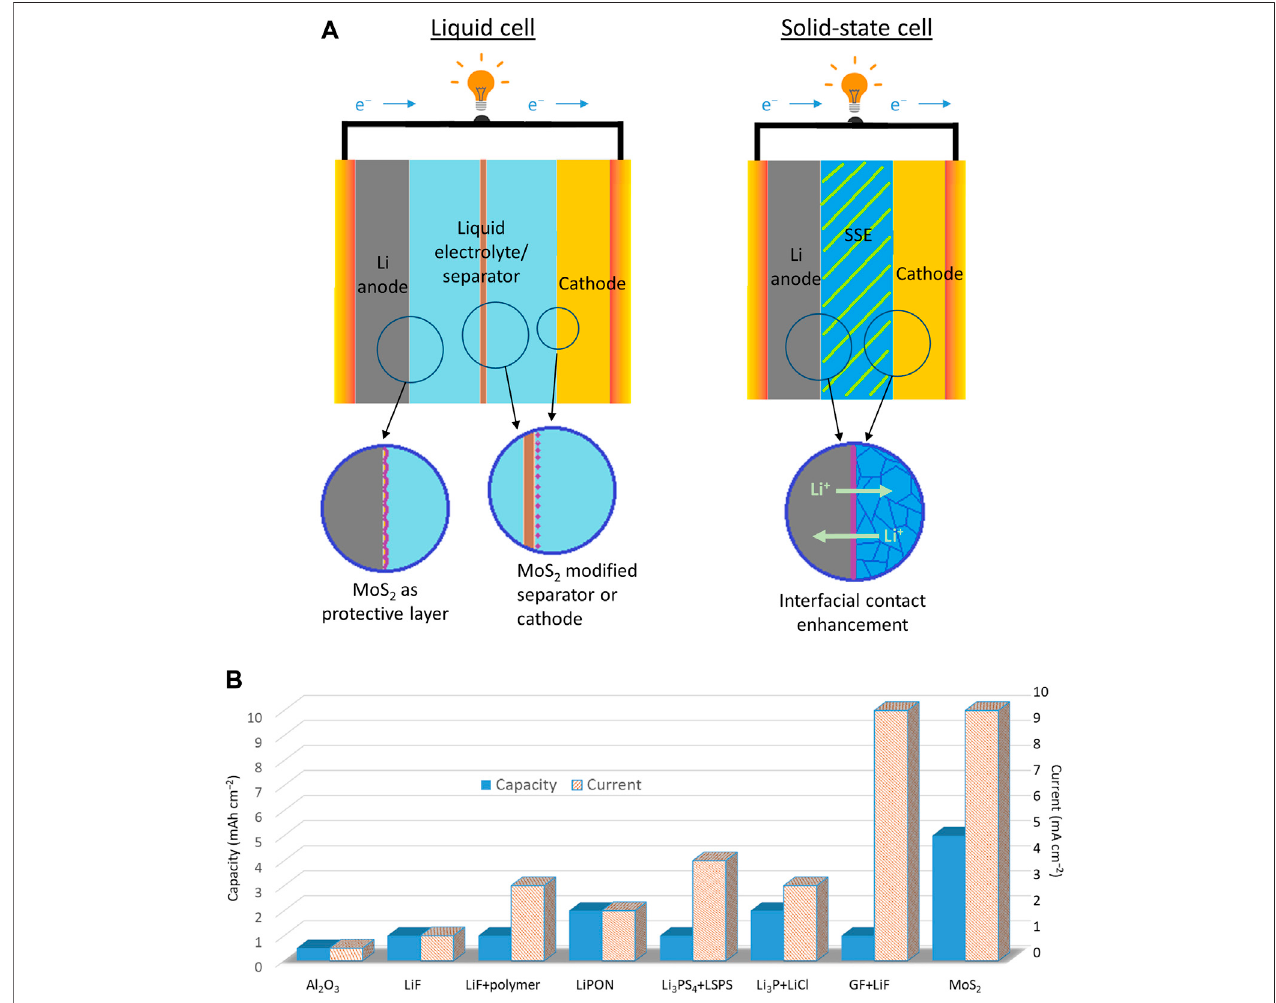
FIGURE1|(A) Applications ofMoS 2 forLimetalbatterysystemsfromliquidcellstosolid-state cells. (B) ThestatisticalanalysisofLi||Lisymmetriccellswithvarious coatings on theLimetal. References forthereported results: Al 2 O 3 (cid:2) Wang etal.,(2018); LiF (cid:2) Chenet al.(2018);LiF+polymer (cid:2) Lang etal.(2019);LiPON (cid:2) Kozenet al. (2017); Li 3 PS 4 +LSPS (cid:2) Pang et al. (2017); Li 3 P+LiCl (cid:2) Lin et al. (2018); GF+LiF (cid:2) Shen et al. (2019); MoS 2 (cid:2) Cha et al. (2018). Conventional Liquid-Type